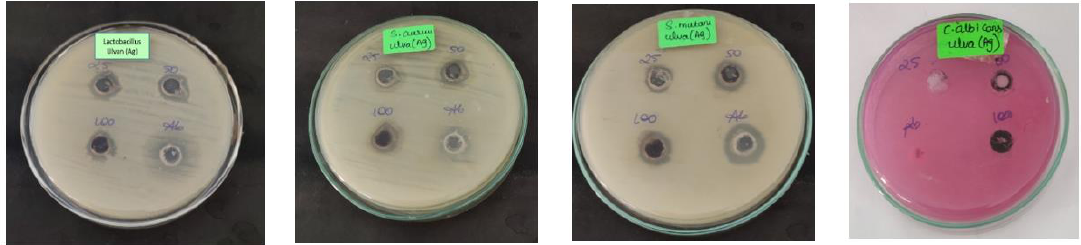
Figure 7. Antimicrobial activity of AgNPs produced with Ulvan from Ulva lactuca ( Lactobacillus , S. aureus , S. mutans, and C. albicans ).